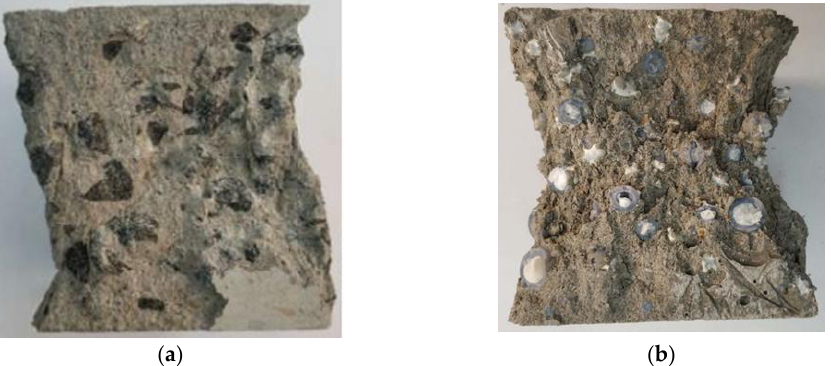
Figure 10. Compressive properties of phase change concrete. ( a ) Basalt aggregate. ( b ) Phase change aggregate.